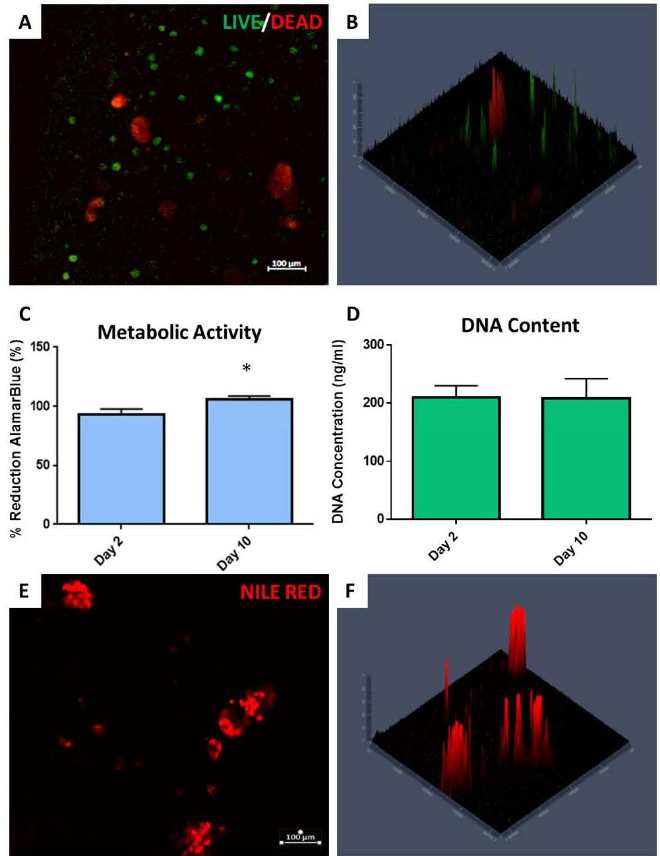
Figure 8. 3D co-cultured cell-laden hydrogels. ( A , B ) LIVE / DEAD ® images with topography map. ( C , D ) AlamarBlue ® and PicoGreen ® quantification of metabolic activity and cell viability. ( E , F ) Nile Red staining of lipids with topography map showilng lipid distribution throughout.